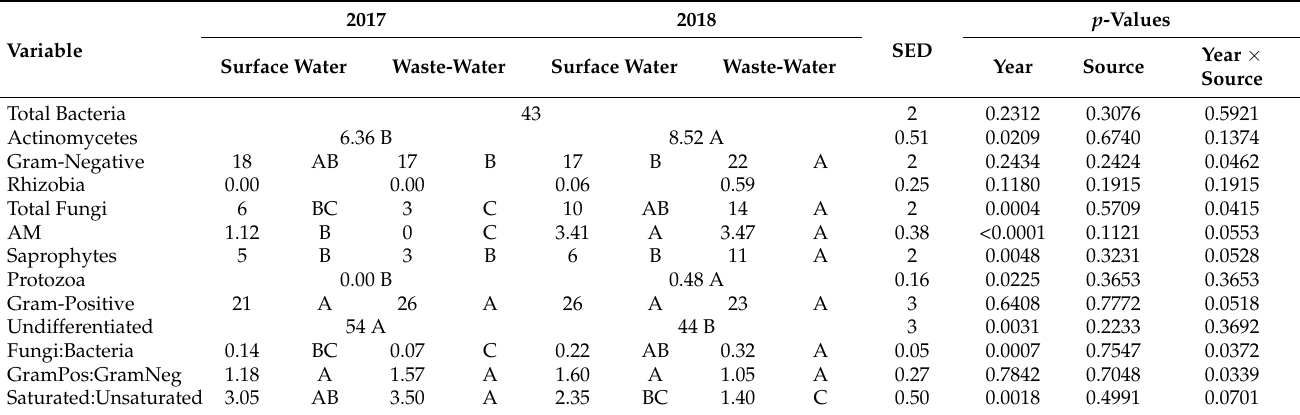
Table 5. Relative abundance values (%) of soil microbial biomass before and one year after alfalfa establishment when irrigated with surface water or treated municipal wastewater (Class 1B, UV- irradiated). Values are the means of four replicates within each water source strip